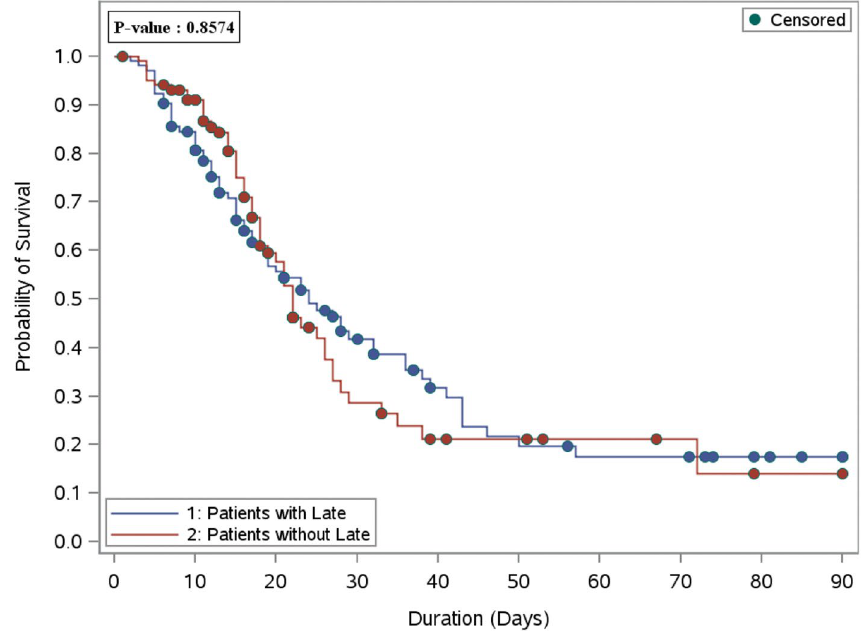
Figure 2. Overall survival plot during the hospital stay after PS matching comparing patients who received late dexamethasone (104 patients) versus the early dexamethasone (104 patients).